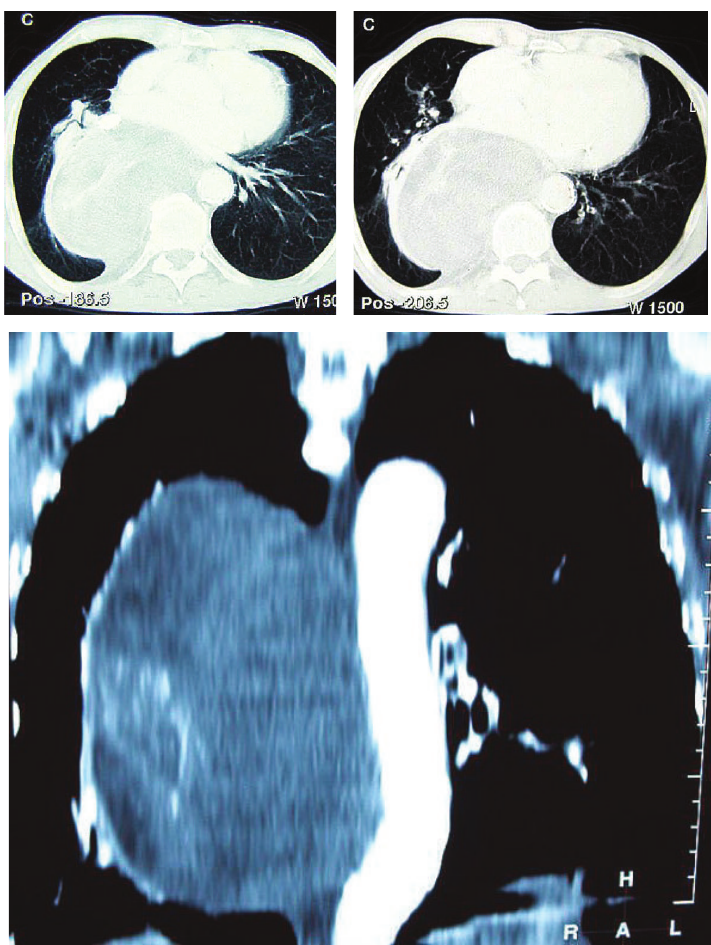
Figure 2: Preoperative CT scan: well-delineated mass with fatty densities and compression on the lung, trachea, right bronchus, and